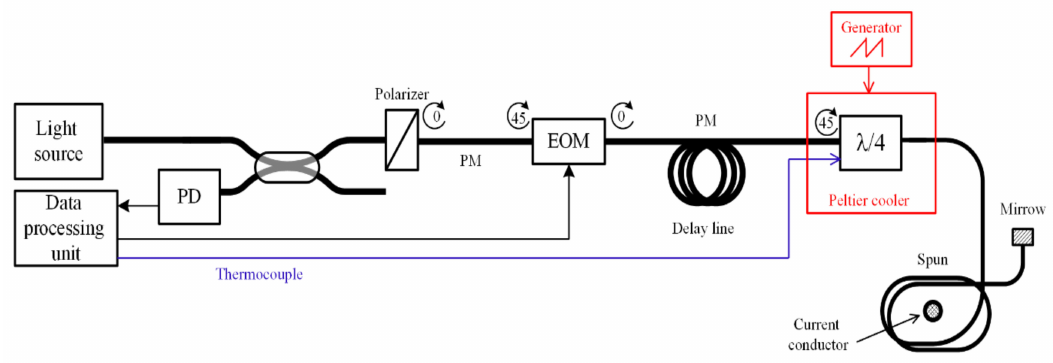
Figure 9. Experimental circuit for research on the e ff ect of the 1